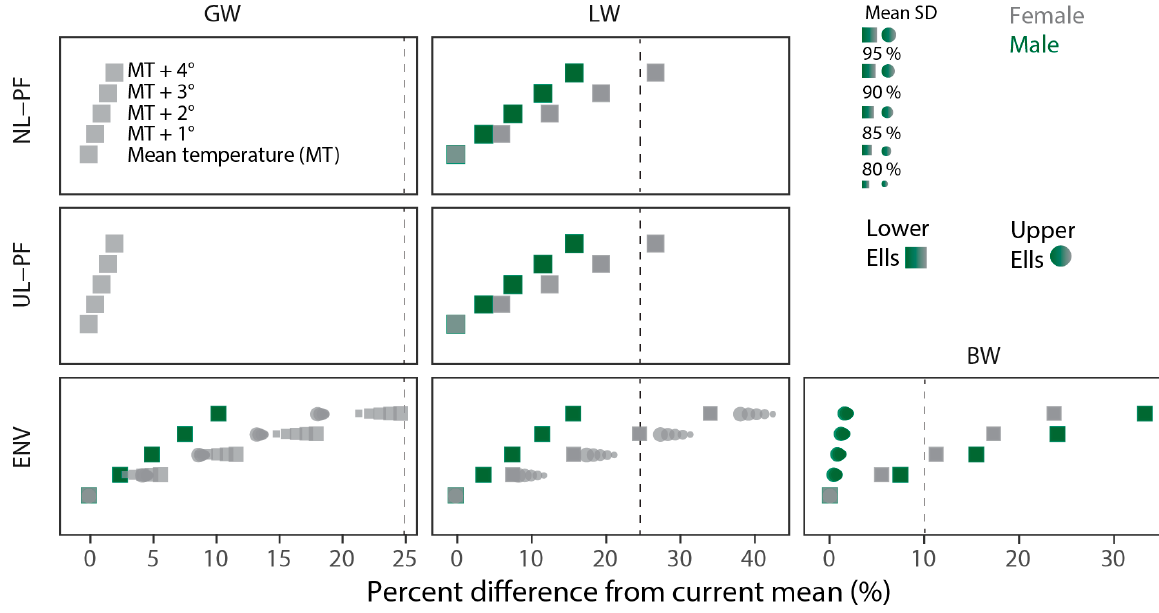
Figure 6. Potential effects of projected future changes in mean air temperature (MT; 1 to 4 °C; vertical scale) and stream discharge (SD; − 5% to − 20%) in Alberta on male and female lake chub captured in the Ells River basin, 2013–2015 and 2018 only among the best ‐ fit models selected by AIC.